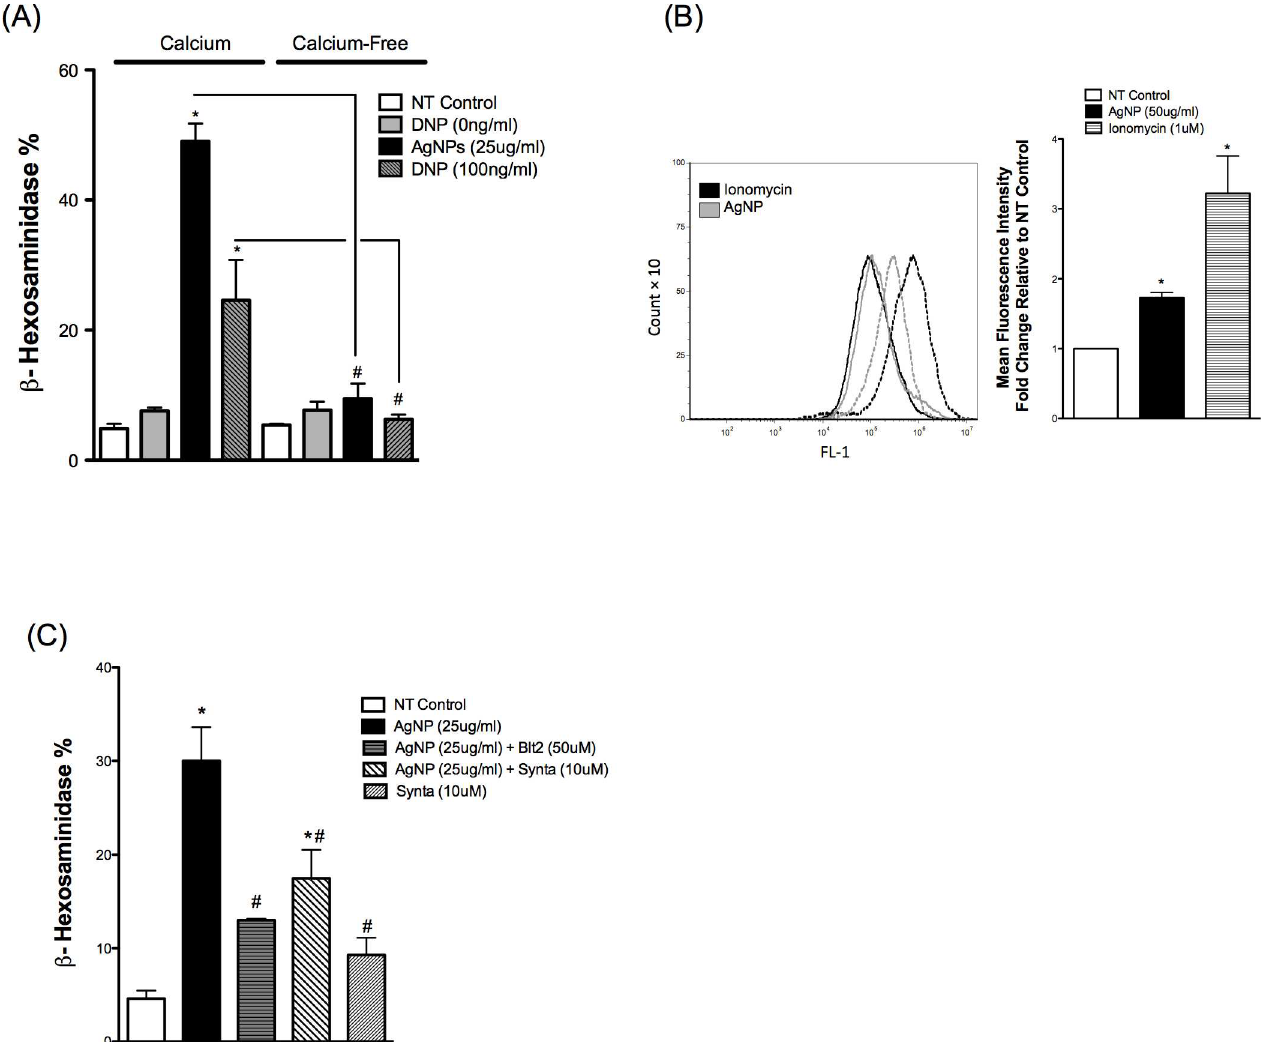
Fig 3. Calcium signal in mast cell following exposure to AgNPs Mast cell degranulation was assessed by measuringthe release of β - hexosaminidase into supernatants. (A) Mast cells degranulation was measuredfollowingexposure to AgNPs in the presenceand absenceof calcium. (B–left panel)Cells were stainedwith Fluo-4 AM (5 μ M) and mean fluorescence intensity was assessed before (baselineNT control, solid line) and after exposure to ionomycin (1 μ M) or AgNPs (50 μ g/ml) (dotted line) for 2 min. (B–right panel)A representative graph of 3 independent experiments showingfold changeof mean fluorescence intensity relative to NT control. (C) Cells were pre-treatedwith the CRAC calcium channels inhibitor Synta (10 μ M) 30 min prior to AgNP (25 μ g/ml) exposurefor 1 h and release of β -hexosaminidasewas assessed. Values are expressedas mean ± SEM of at least 3 independentexperiments. * Indicatessignificantdifference from controlledgroup (p (cid:20) 0.05). #Indicatessignificant difference from indicatedgroups (p (cid:20)